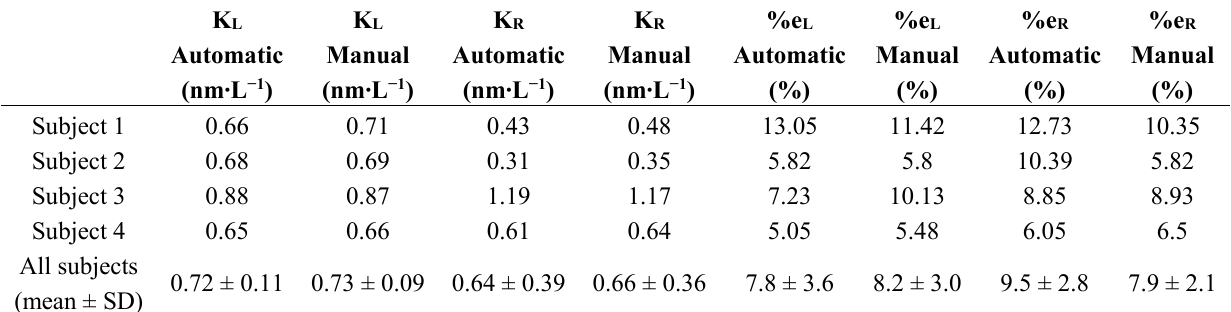
Table 1. Mean sensitivity of the textile for UT L (K L ) and UT R (K R ) and percentage error of the system for estimating UT L (e L ) and UT R (e R ) with both automatic and manual method of peak selection. These data are reported considering both the single subjects and the average value and standard deviation among all the subjects (last